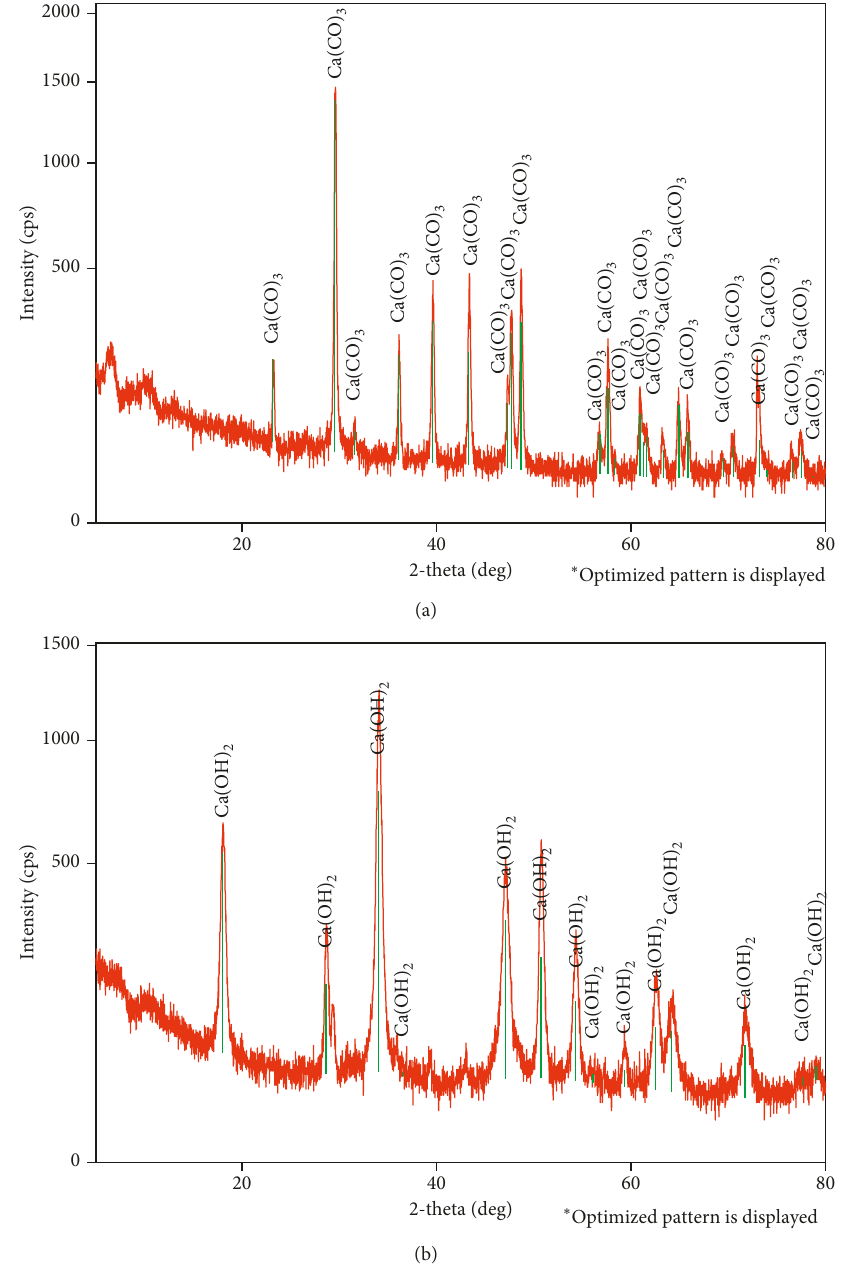
Figure 1: X-ray diffraction patterns: (a) raw egg shell powder; (b) calcined egg shell